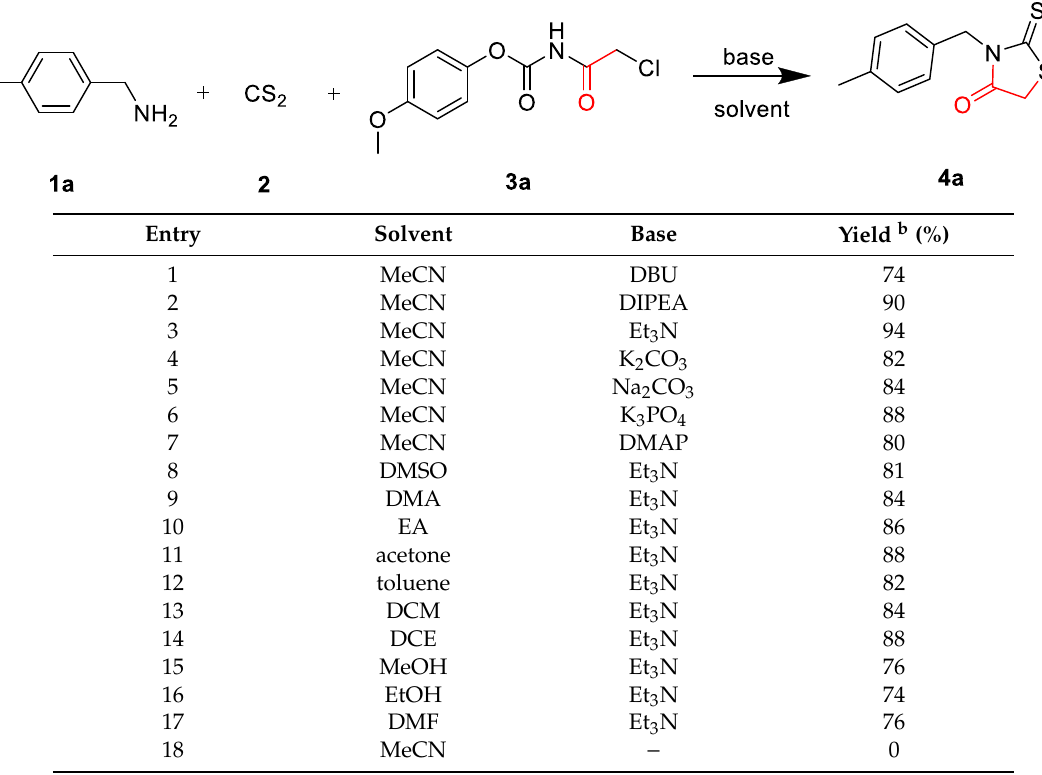
Table 1. Optimization of reaction conditions a.